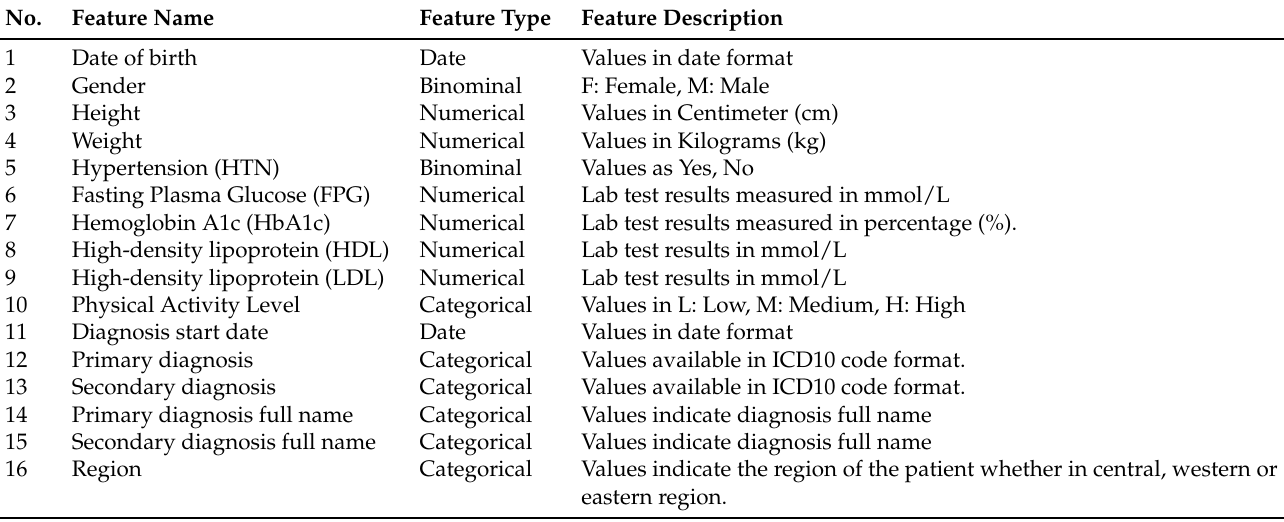
Table 1. The set of features selected in our dataset for classification of diabetic and prediabetic